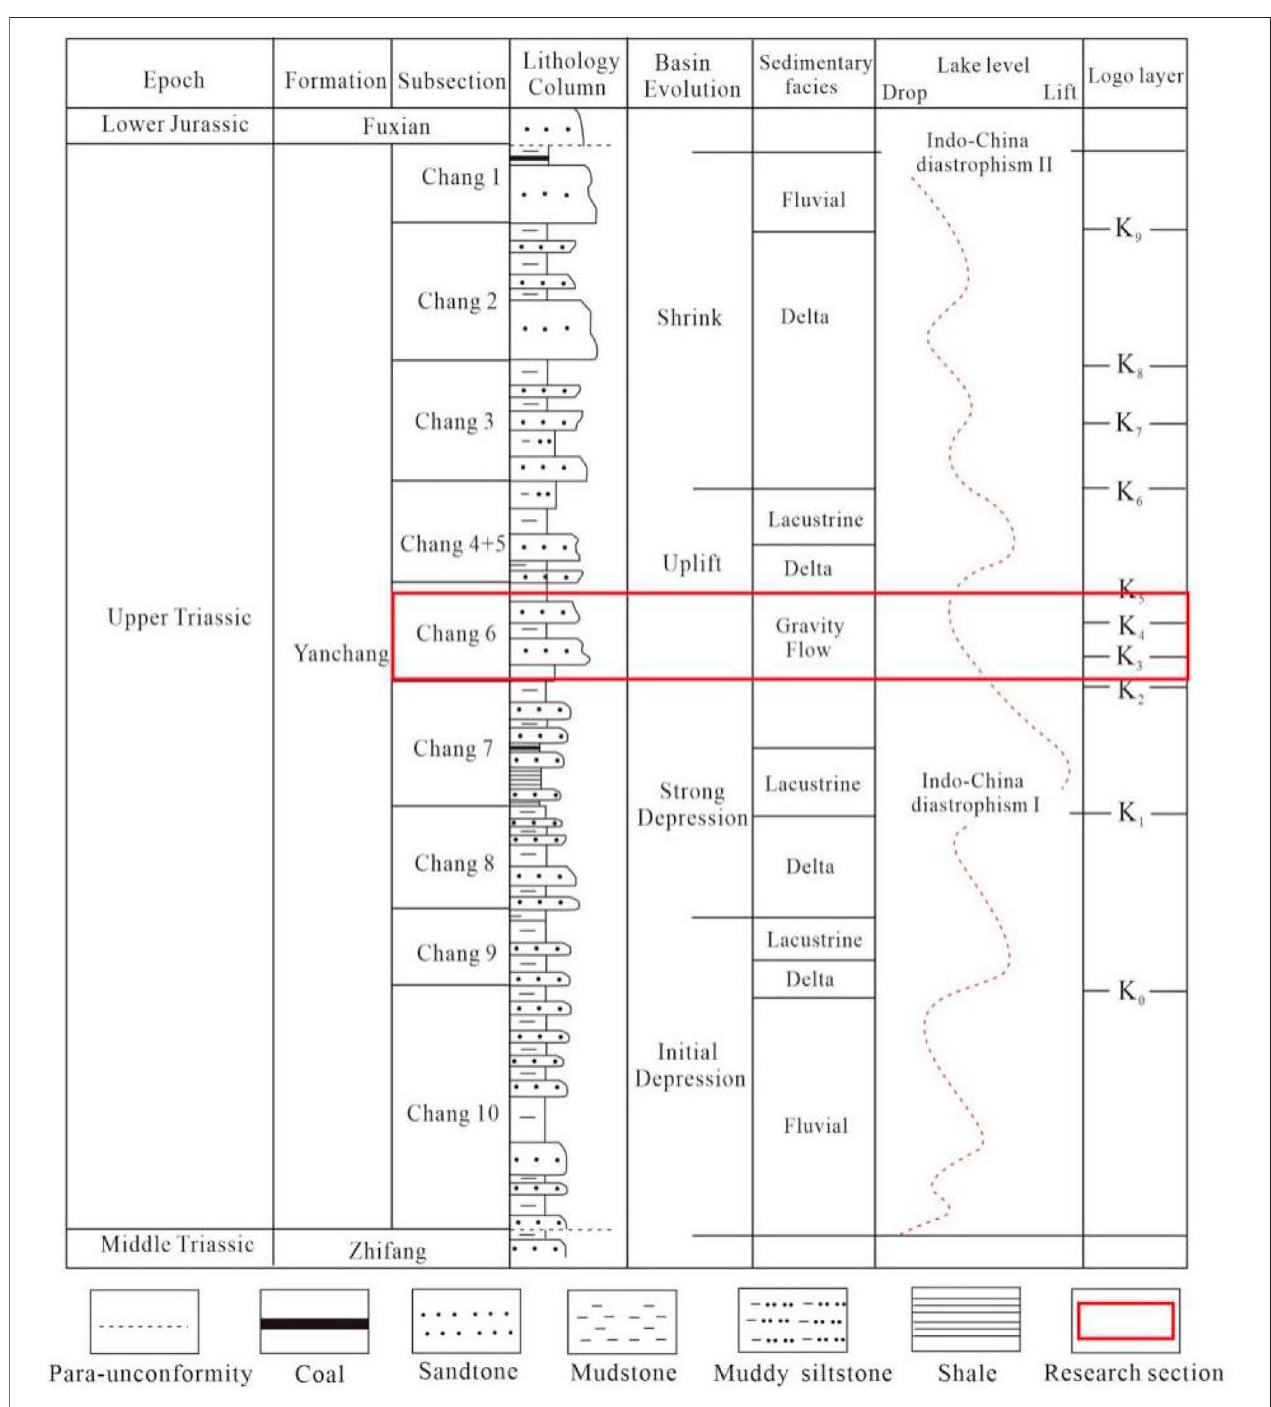
FIGURE2| Histogramofsedimentary evolutionoftheYanchangFormation (histogramofsedimentary evolutionoftheYanchangFormation fromRanetal.,2019).